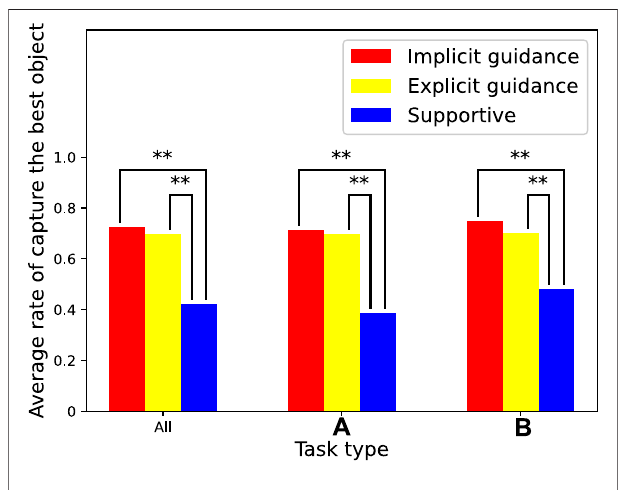
FIGURE 4 | Average rate of capturing best object.